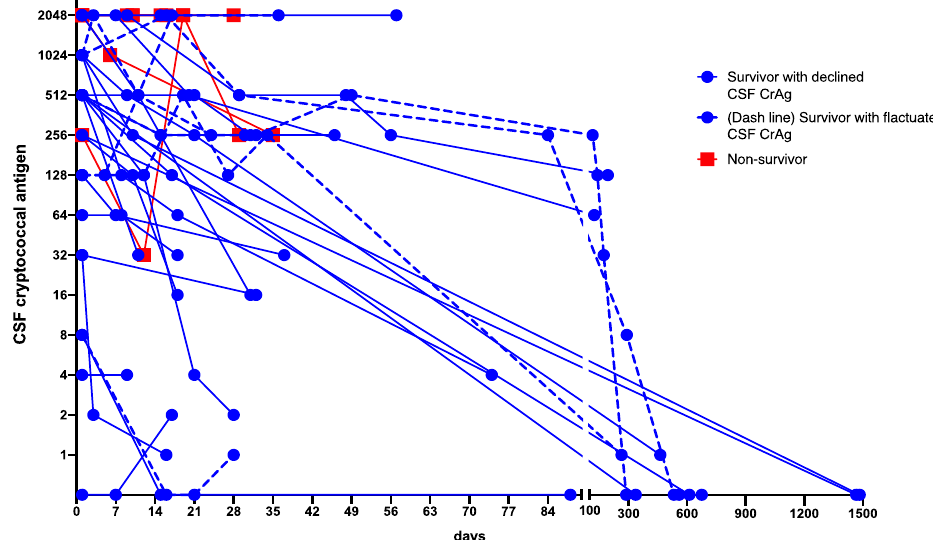
Figure 2. Evolution of CSF CrAg titers in 34 patients who had more than 1 determination of CrAg titers according to the day of diagnosis. CSF CrAg titer > 1024 is presented as 2048. CSF, cerebrospinal fluid; CrAg, cryptococcal antigen.